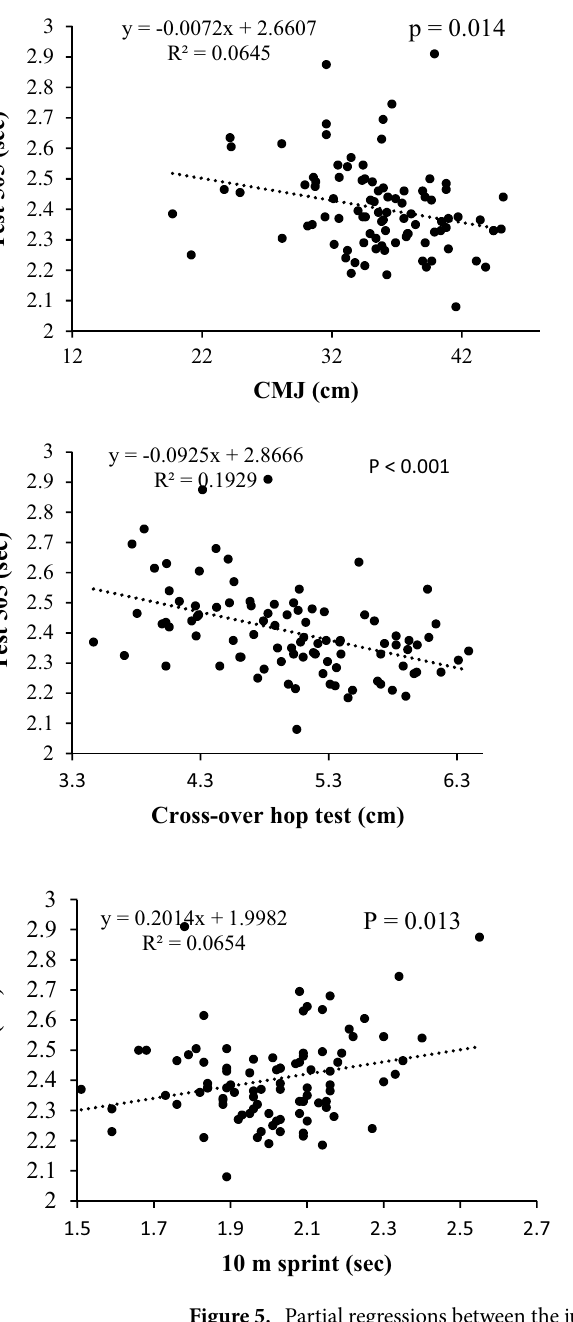
Figure 5. Partial regressions between the jump test (CMJ), the dynamic balance test (cross-over hop test), the sprint test (10 m) and the change of direction test performed (505 test and 90° COD test).